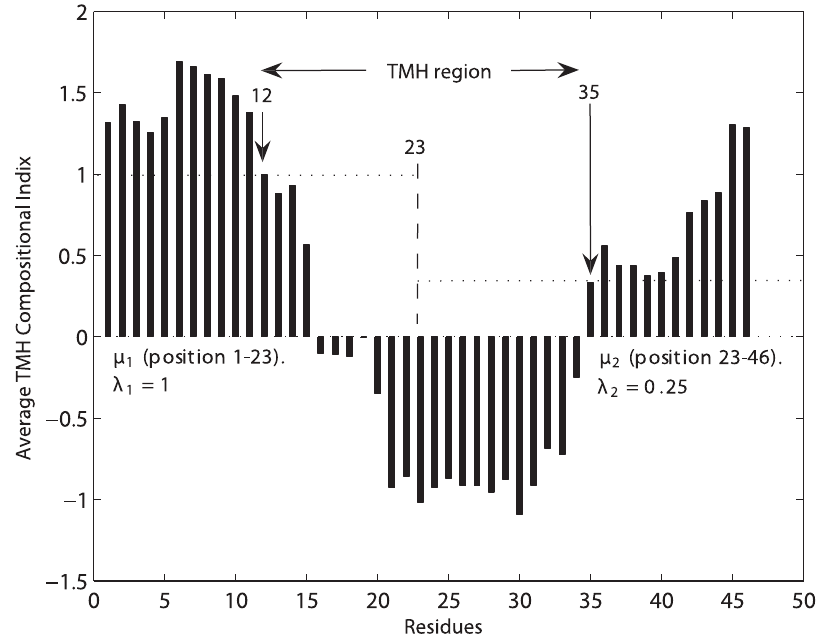
Figure 7. TMH segment detection in protein 1OCC using GA.